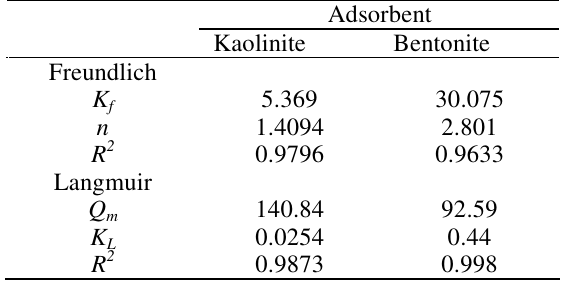
Table 11. Freundlich and Langmuir constants for nickel(II)